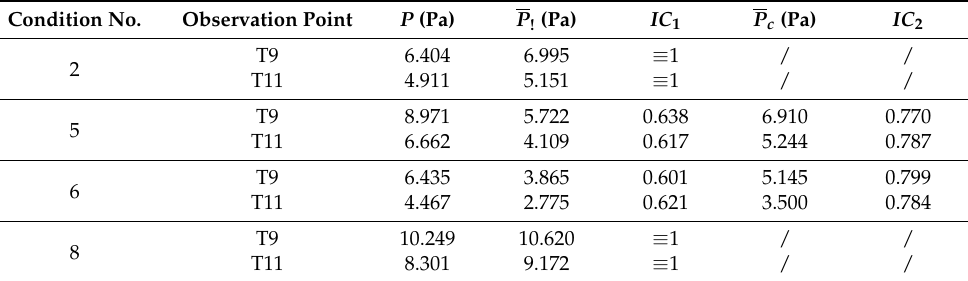
Table 6. Influence coefficient of multi vibration source of LFN.